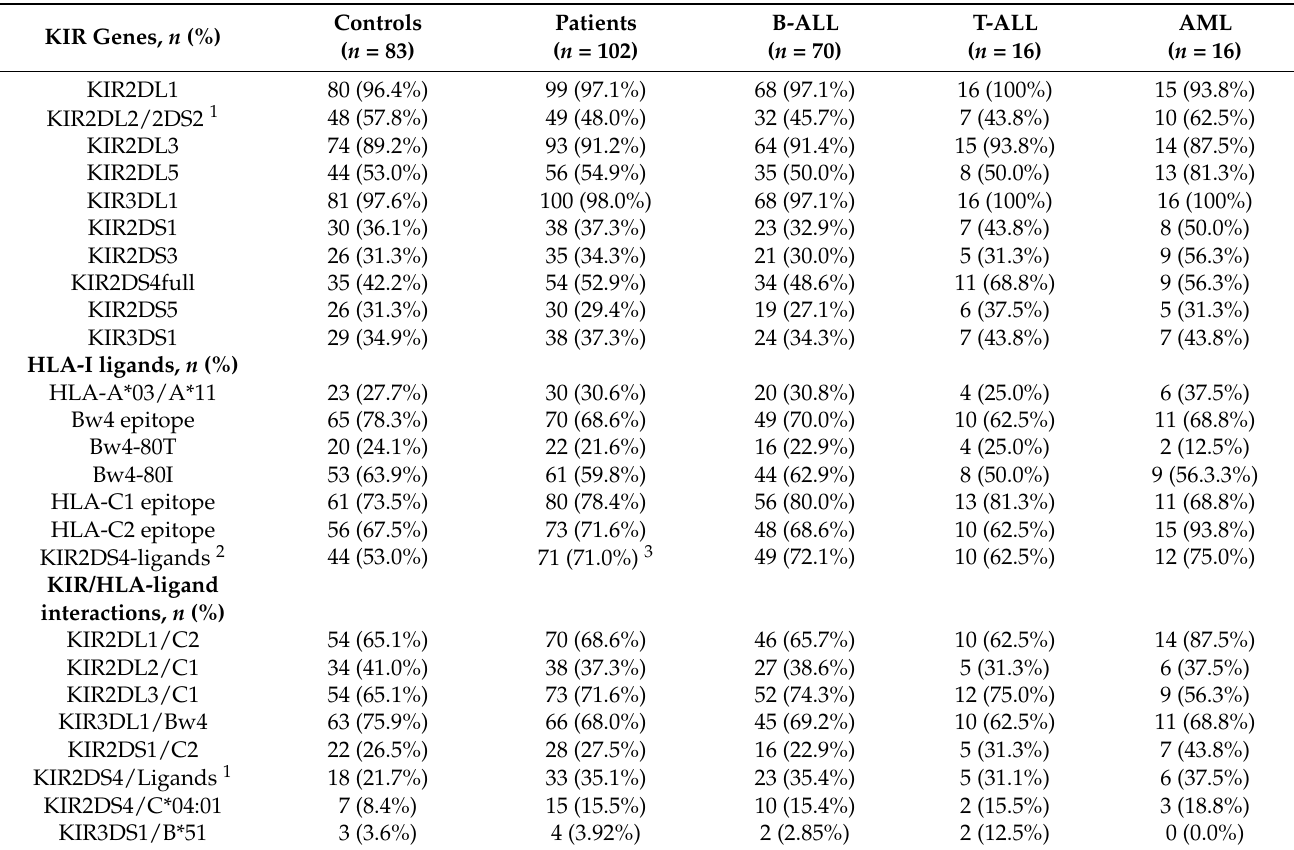
Table 2. KIR gene, HLA-I ligand, and KIR/HLA-I ligand interaction frequencies in controls and